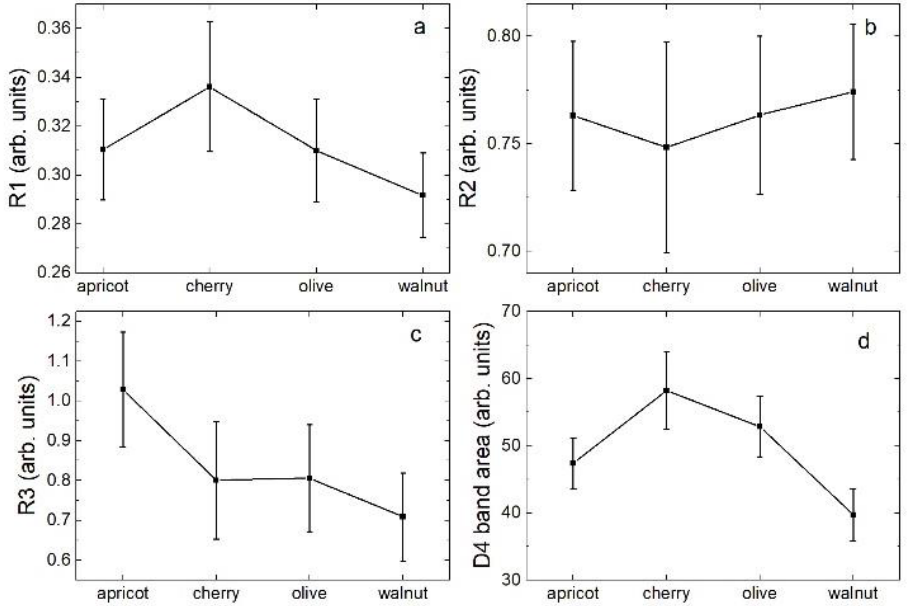
Figure 8. Values of the R1 ( a ), R2 ( b ), and R3 ( c ) parameters, and of the D4 band area ( d ) used to characterize the samples Raman spectra as a function of the source of the carbon powder as explained in the text.